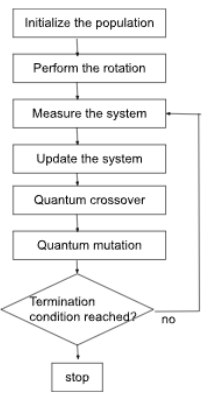
Figure 1 : Flowchart of the proposed methodology 2.4.1